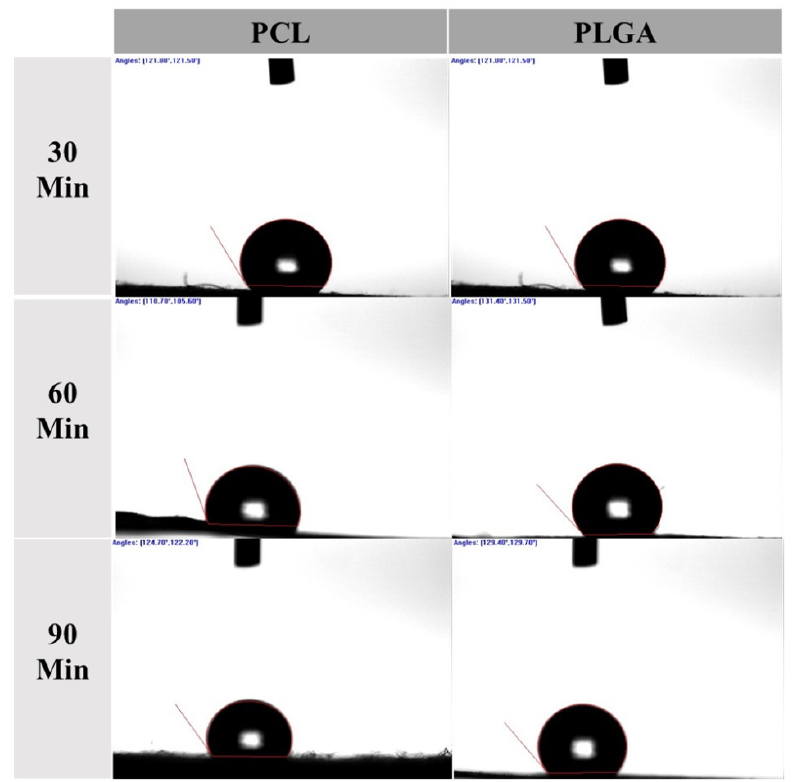
Figure 2. Contact angle measurements using a goniometer to investigate the wettability of both PCL and PLGA scaffolds. Table 2. Mean ± SEM of contact angle measurements of PCL, PLGA scaffolds.